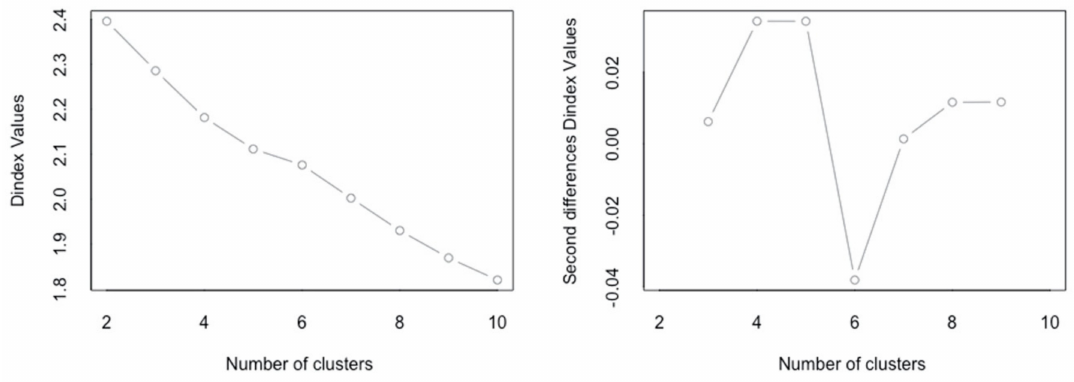
Figure 2. Number of clusters using NbClust.